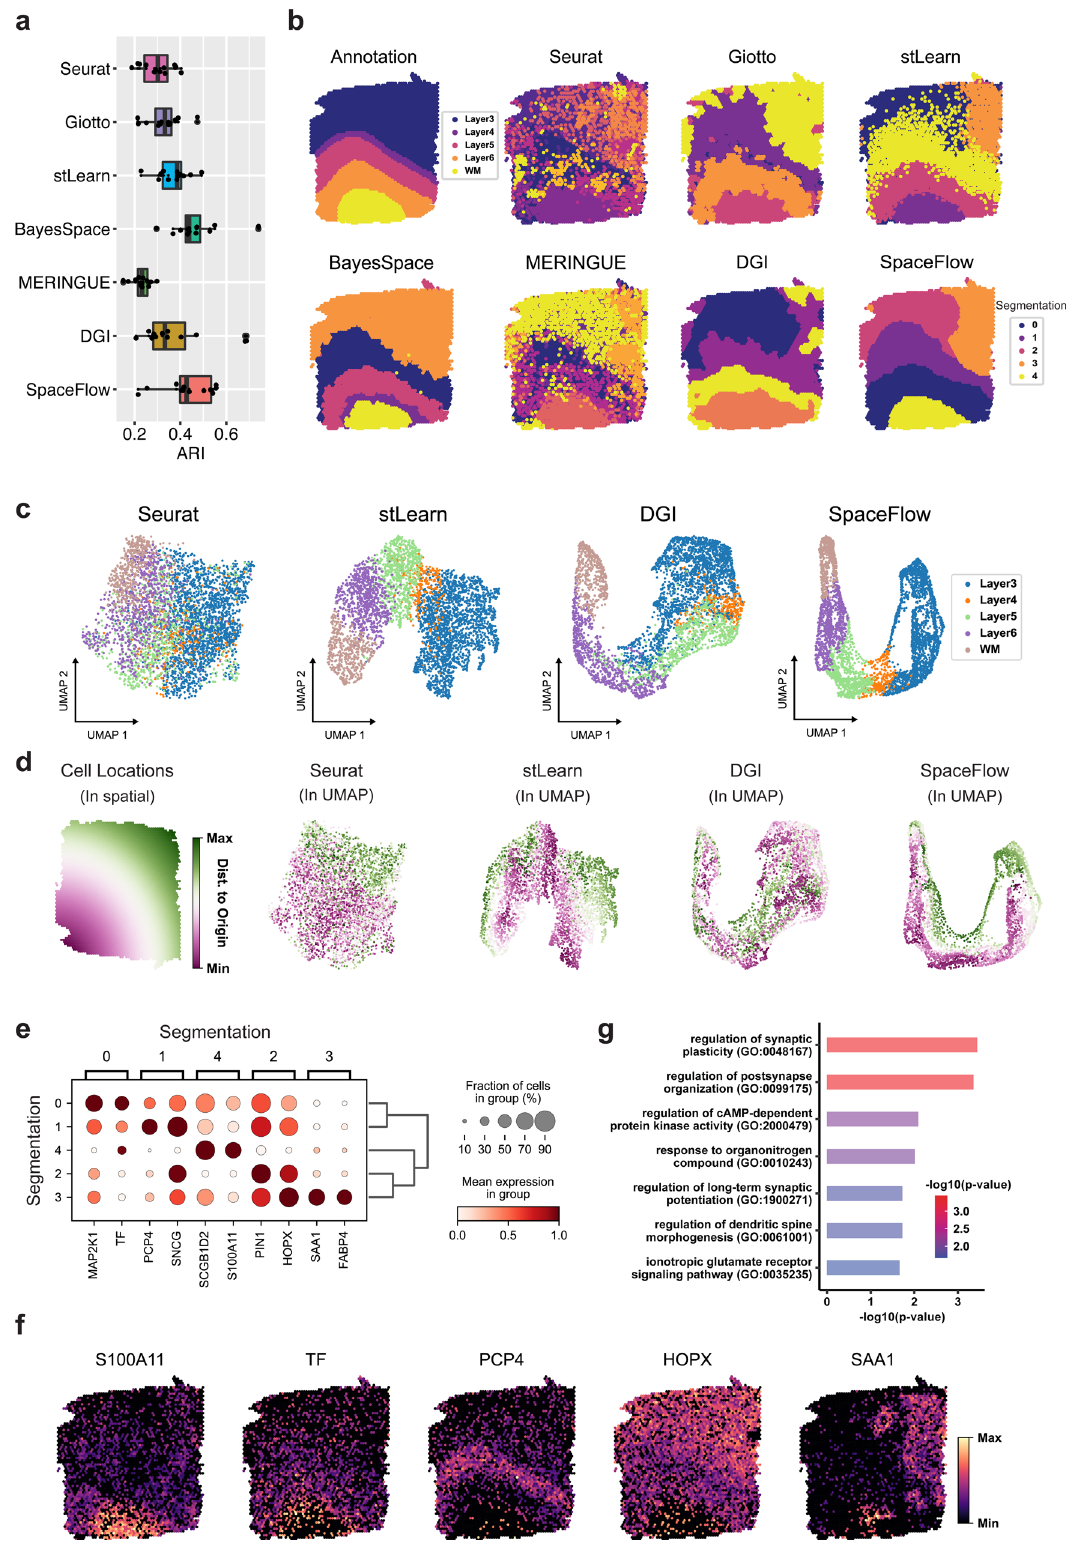
To study how the low-dimensional embeddings from different methods encode spatial information, we show the same UMAP embeddings colored by the spatial distances between the spot